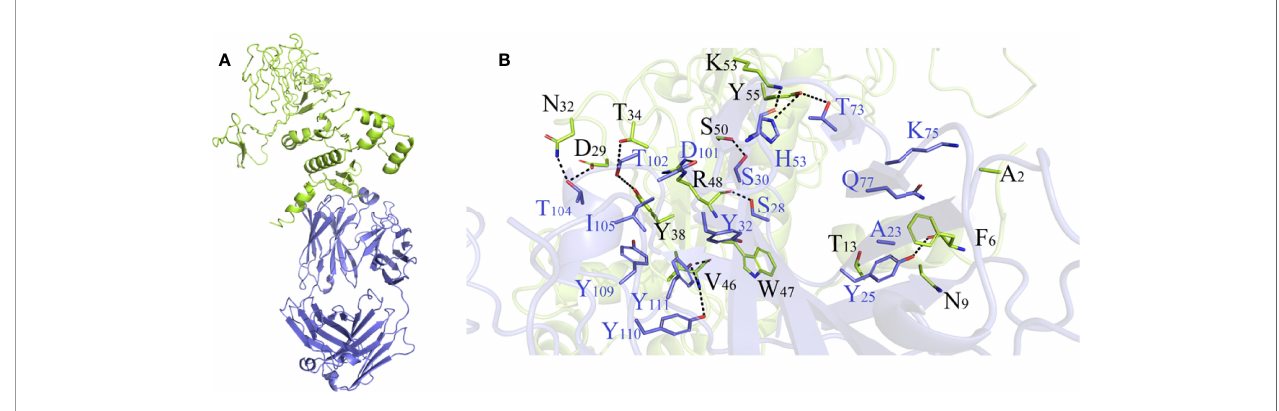
FIGURE 7 | (A) Diagram of the lowest energy docking mode of the vaccine-B cell receptor (BCR) complex. (B) Pattern diagram of the binding interface of the vaccine – BCR complex, the BCR is shown in blue, the vaccine is shown in yellow-green. The binding interface amino acid of BCR is shown in blue, the binding interface amino acids of vaccine are shown in black. The sticks refer to binding interface amino acids, and the black dotted lines refer to hydrogen bonds.